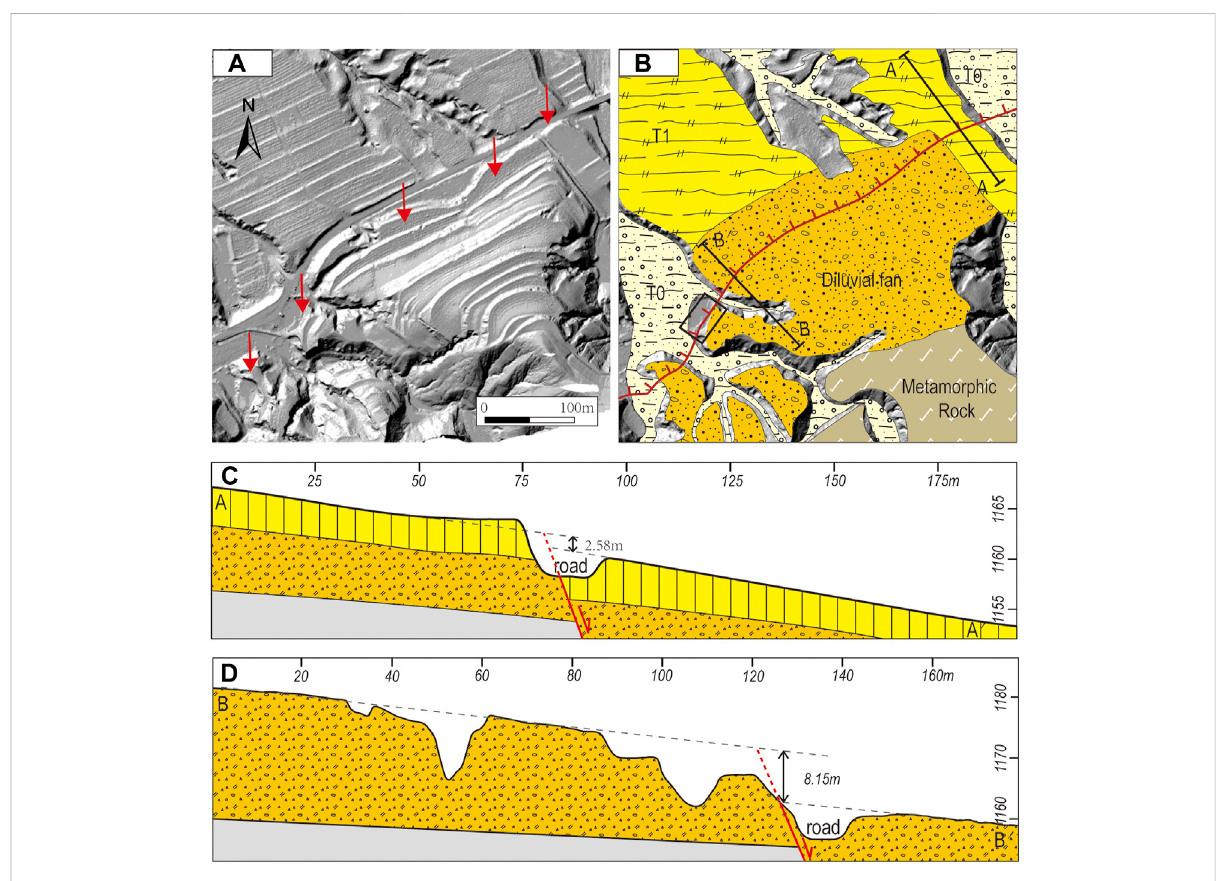
FIGURE 3 Tectonic landforms and simpli fi ed stratigraphy pro fi le near the Xujiabao trenching site. (A) s-UAV (small unmanned aerial vehicle) DEM imagery of the Xujiabao alluvial fan, where red arrows represent the trace of the Liulengshan Fault; (B) interpreted map. The red line indicates the trace of the Liulengshan Fault; T0 – T1, alluvial phases; the black box in Figure 3B indicates the position of the trench; (C) and (D) as the topographic pro fi les for A – A ′ and B – B ′ in (B) , respectively. The color version of the fi gure is available only in the electronic edition.